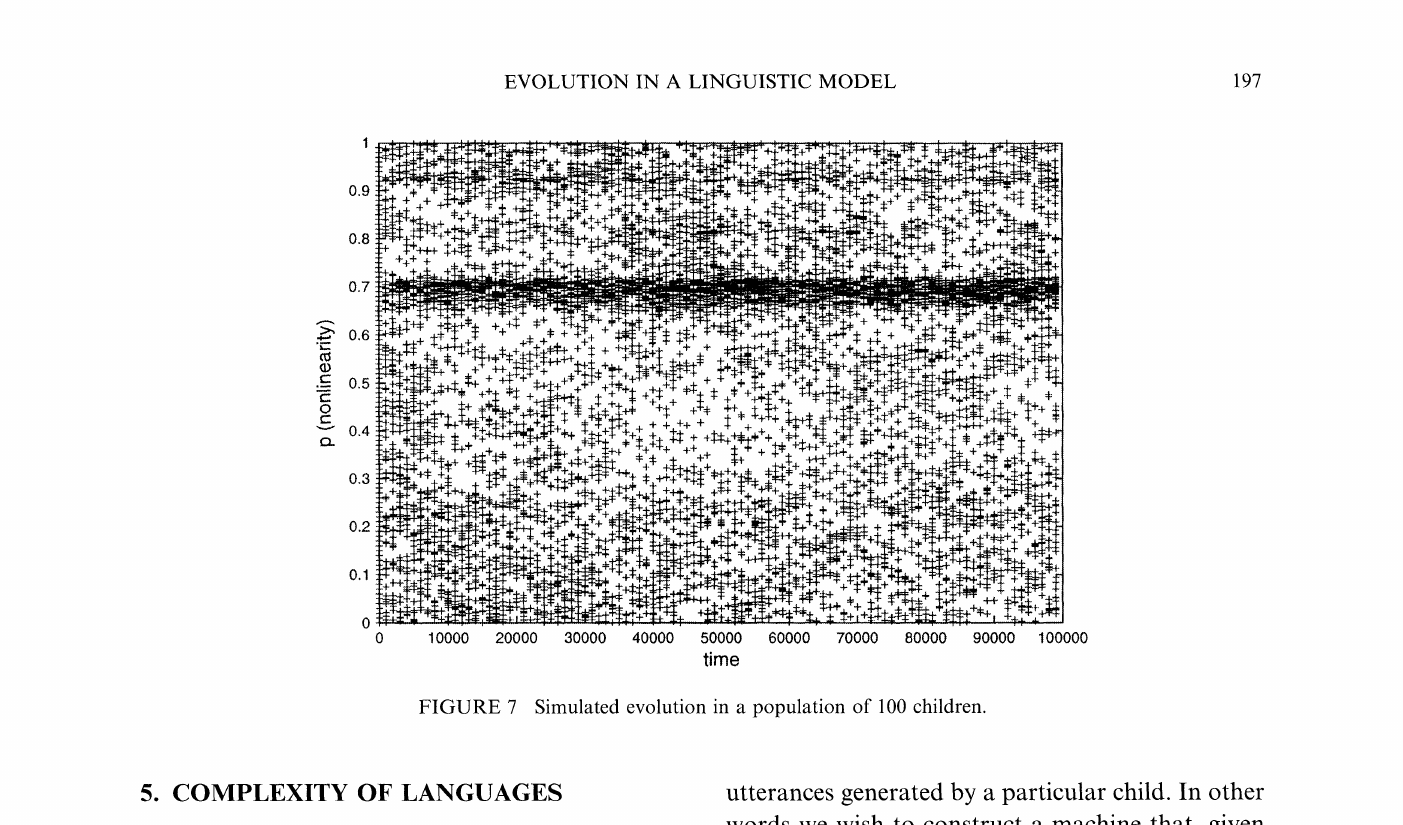
FIGURE 7 Simulated evolution in a population of 100